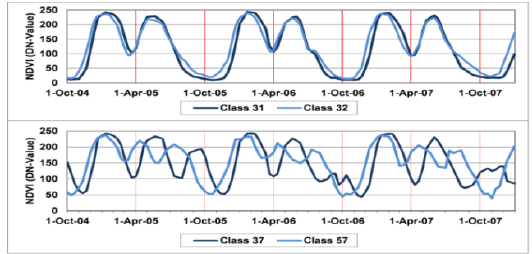
Figure 3. NDVI curves of two selected cases of two and three rice land use systems in Mekong delta,